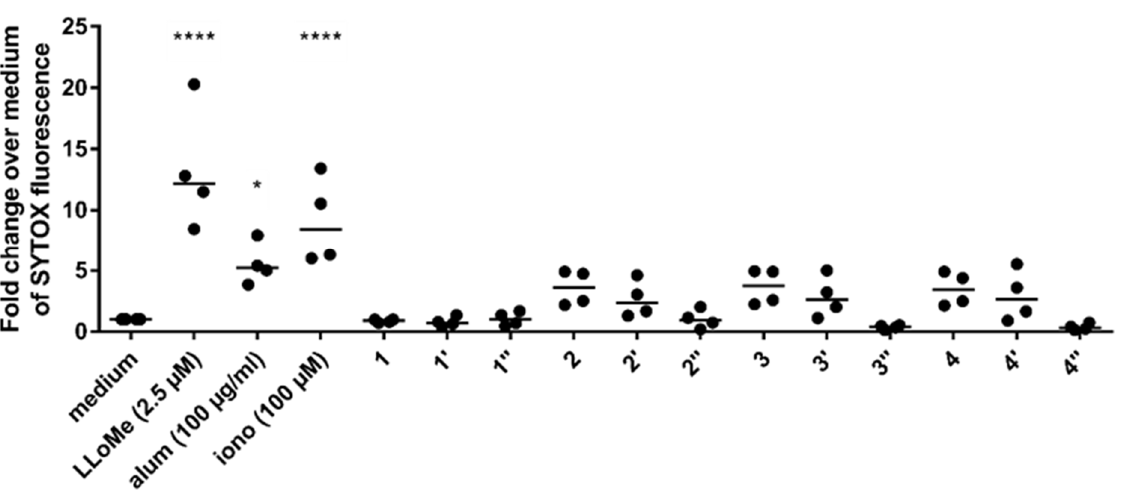
Figure 3. Peptides and silica particles trigger NET formation. The release of DNA was measured by fluorescence of SYTOX™ orange bound to extracellular DNA in plate reader assays in response to treatment with peptides ( 1 , 2 , 3 and 4 ) silica particles ( 1′ , 2′ , 3′ and 4′ ) and calcinated silica particles ( 1″ , 2″ , 3″ and 4″ ). L -leucyl- L -leucine methyl ester hydrochloride (LLoMe), alum and ionomycin (iono) were used as positive controls. One representative experiment using neutrophils from different donors (horizontal bar, median). Differences were considered statistically significant for values of p ≤ 0.05. Note: p ≤ 0.05 (*), p ≤ 0.0001 (****).